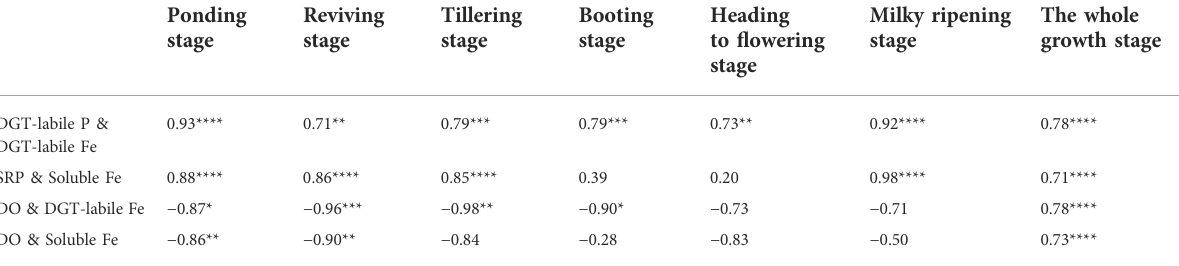
TABLE 3 Pearson correlation coef fi cients r between vertical DO, P, and Fe concentrations in paddy